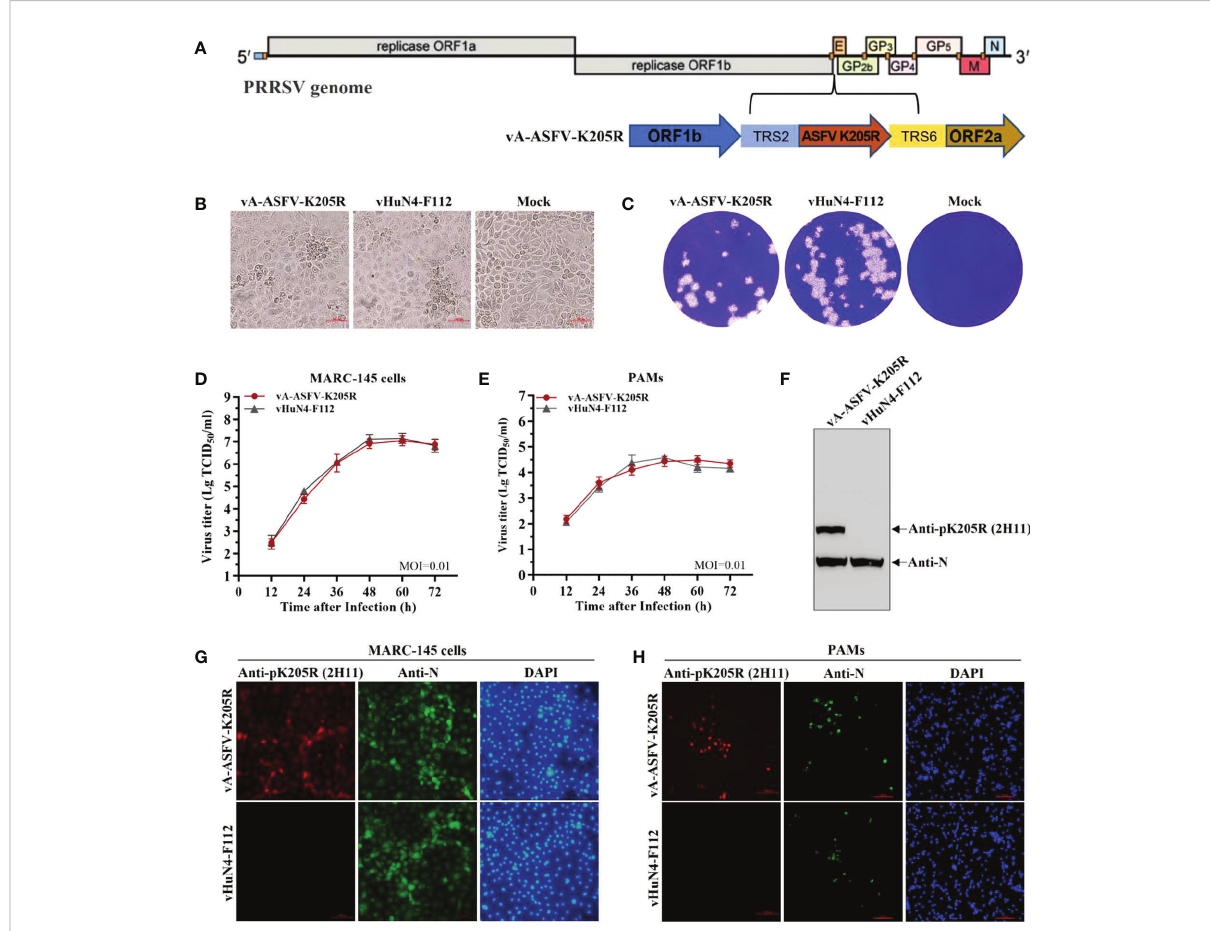
FIGURE 5 2H11 speci fi cally recognized the recombinant PRRSV expressing pK205R. (A) The schematic representation of recombinant PRRSV virus expressing ASFV pK205R construction. (B, C) CPE and plaque morphology investigation. MARC-145 cells were infected with vA-ASFV-K205R and vHuN4-F112 (MOI = 0.001). The mock control represented non-infected MARC-145 cells. The MARC-145 cells were monitored or stained with crystal violet at 3 days post-infection. (D, E) Growth characteristics of vA-ASFV-K205R and vHuN4-F112 were evaluated in MARC-145 cells (D) and PAMs (E) . (F) MARC-145 cells were infected by vA-ASFV-K205R and vHuN4-F112. WB analysis of cell lysates using an anti-N and anti- pK205R antibody. (G, H) IFA against the N protein or pK205R in MARC-145 cells (G) and PAMs (H) at 36 hpi with vA-ASFV-K205R and vHuN4- F112 (MOI = 0.1). Scale bar = 100 m